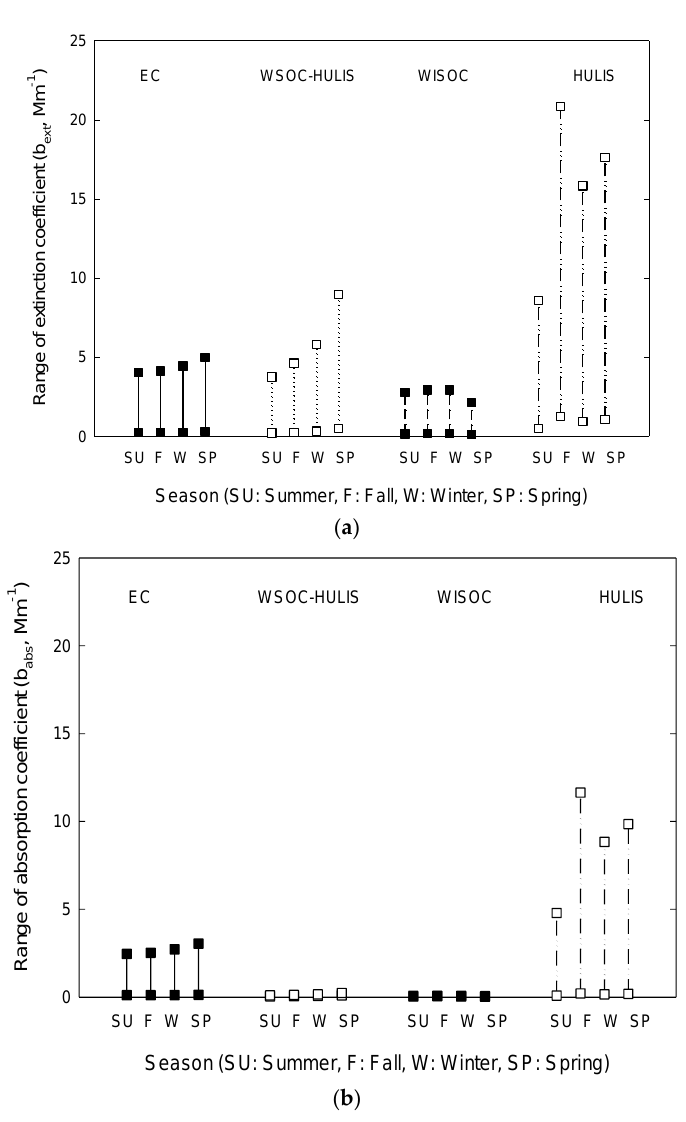
Figure 4. Seasonal variation of the range of ( a ) extinction and ( b ) absorption coefficients for each carbonaceous component (0.1 µm < d g < 1.0 µm, 1.1 < σ g < 2.0, 0.006 < HULIS IRI < 0.3). Table 2. Seasonal variation of radiative forcing when the imaginary refractive index of HULIS changes from 0.006 to 0.3. (0.1 µ m < d g < 1.0 µ m, 1.1< σ g <2.0, 0.006 < HULIS IRI <